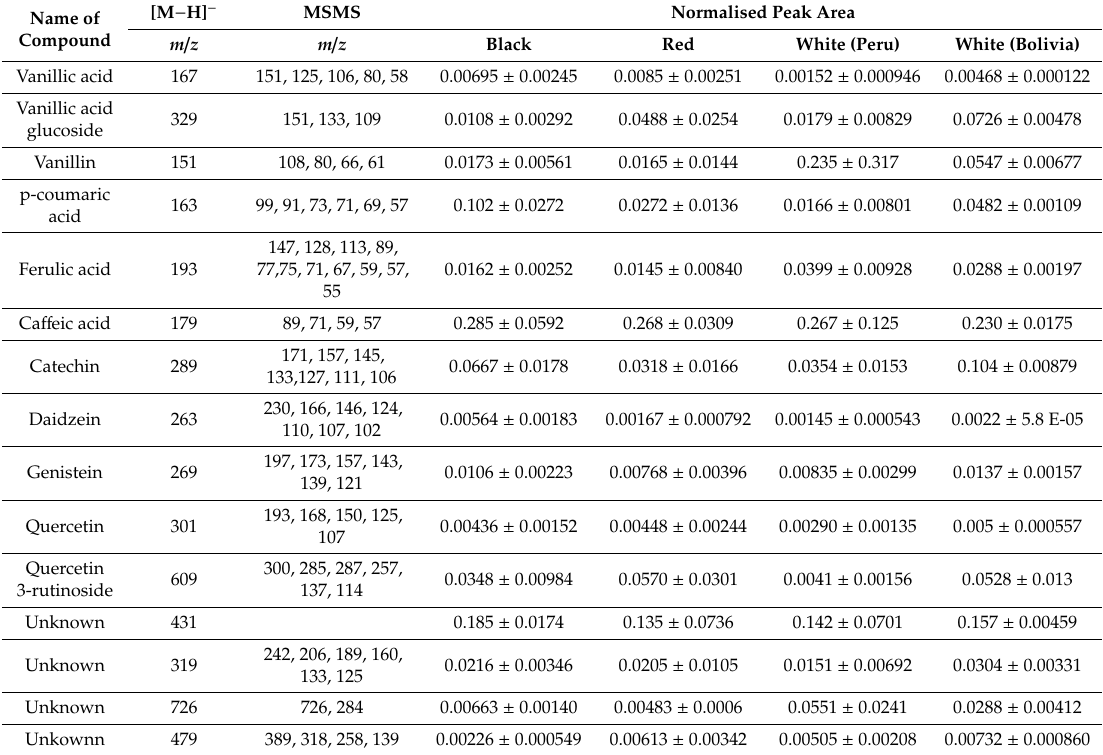
Table 1. Normalised peak area of the pulverised, black, red and white (Bolivia and Peru) derived from LC / MS analysis. Data expressed as mean ± SD ( n =